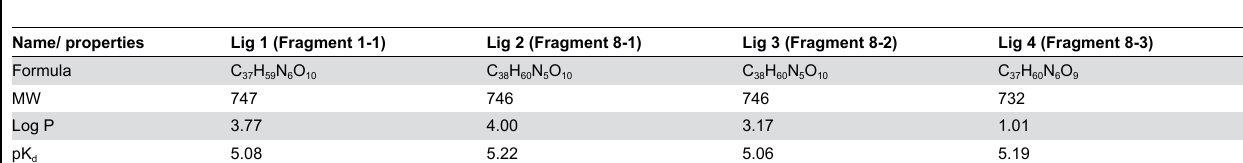
Table 4. Detailed structural information and properties of the four linked molecules.